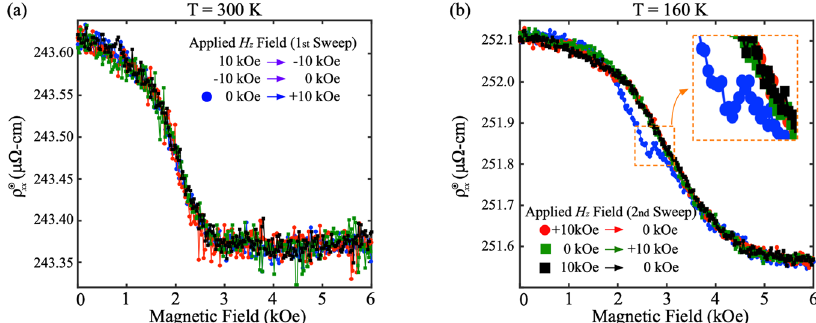
Fig. 3 Field history effects on transport properties of the Fe/Gd patterned wire. a , b Field-dependent polar longitudinal resistivity ( ρ (cid:1) xx ) of the 10 μ m-wide Fe/Gd patterned wire at a T = 300 K and b T = 160 K under two consecutive fi eld history protocols. The inserts in a , b show the H z fi eld sweep protocols for the four fi eld-dependent ρ (cid:1) xx responses (blue, red, green, black-colored datasets) that were obtained in sequential order at each temperature: the fi rst sweeps are detailed in a , while the subsequent fi eld sweeps are shown in b